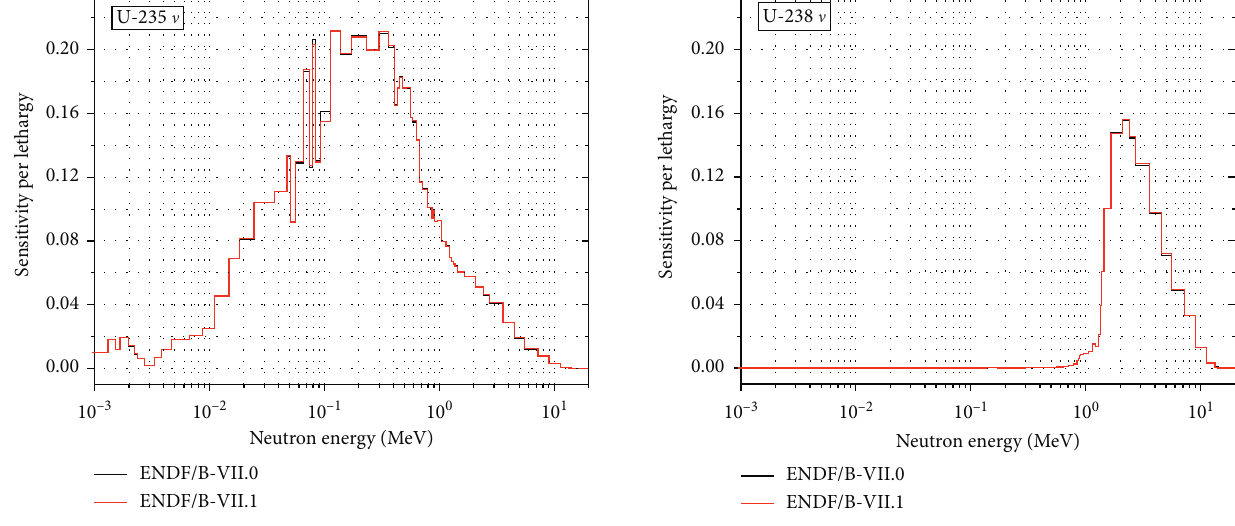
to 235 U total ] cross eff